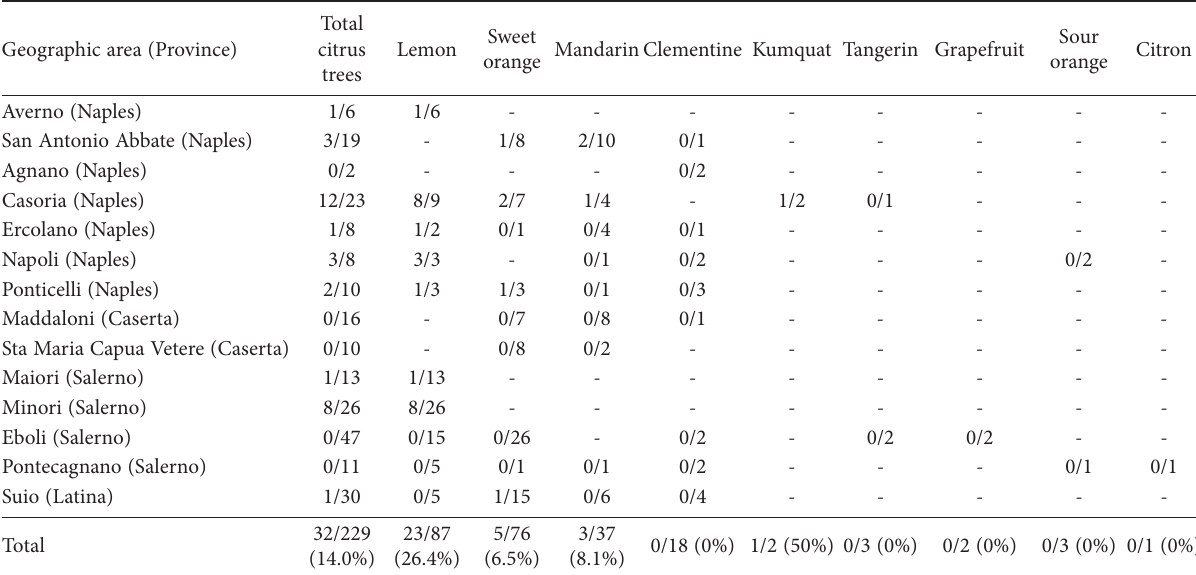
Table 2. Survey of citrus vein enation virus in different orchards of Campania region and one orchard of Latina province. Number of CVEV infected trees /number of total trees analyzed is